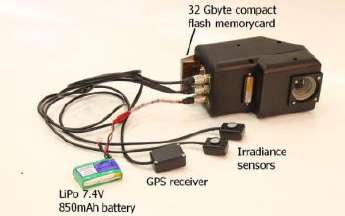
Figure 1. The Fabry-Perot interferometer spectral camera with GPS receiver, battery and irradiance